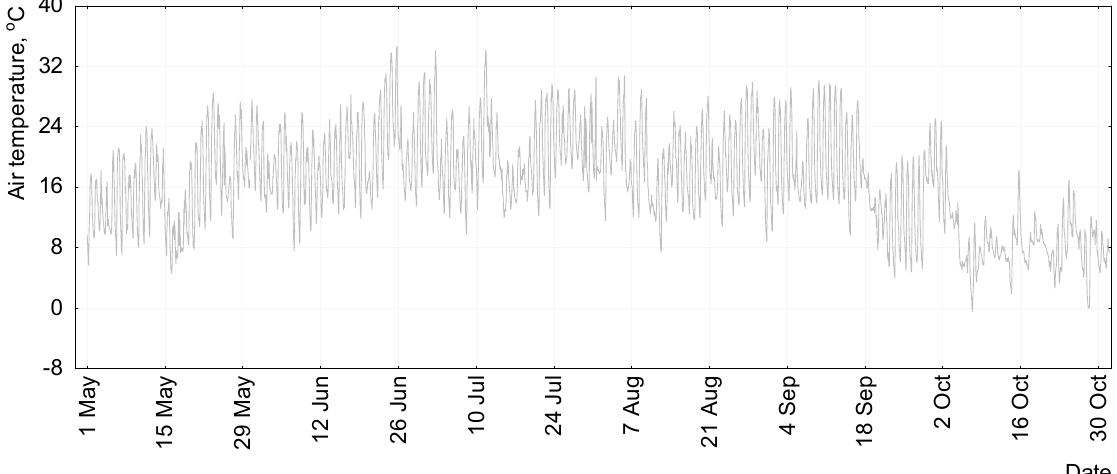
Figure 7. External air temperature, 1 May–31 October.